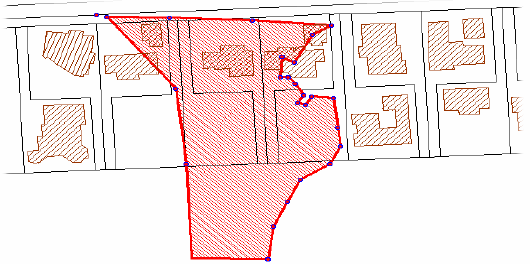
Figure 3: GPS-surveyed polygon data, overlaid on line data depicting buildings and cadastral